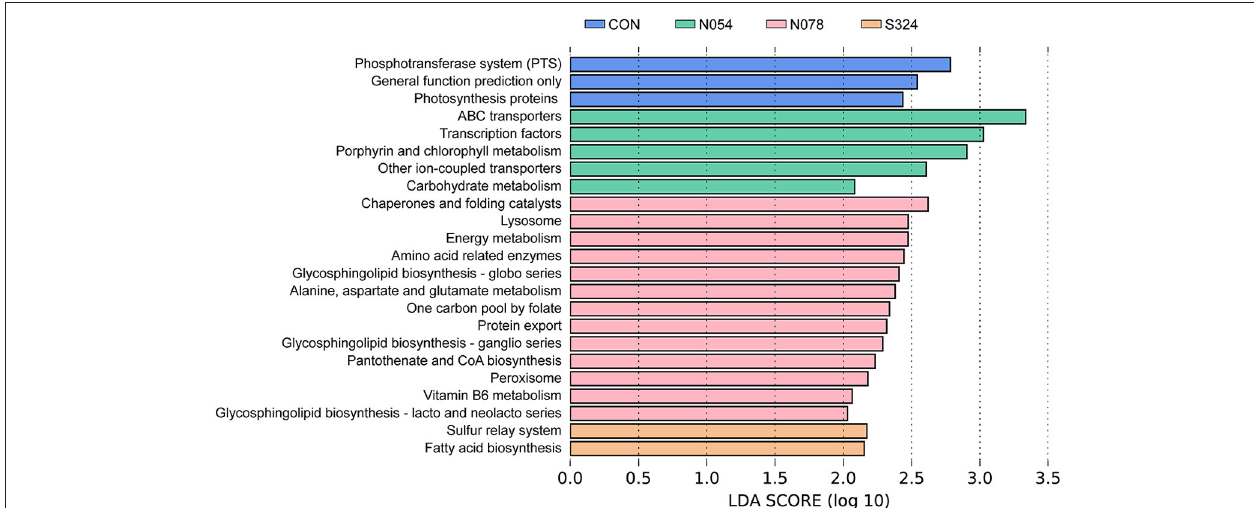
FIGURE 4 | LEfSe analysis on predictive functions of KEGG level 3 identified via PICRUSt. A Log LDA > 2.0 was considered as significant difference. KEGG, Kyoto Encyclopedia of Genes and Genomes; PICRUSt, Phylogenetic Investigation of Communities by Reconstruction of Unobserved States.